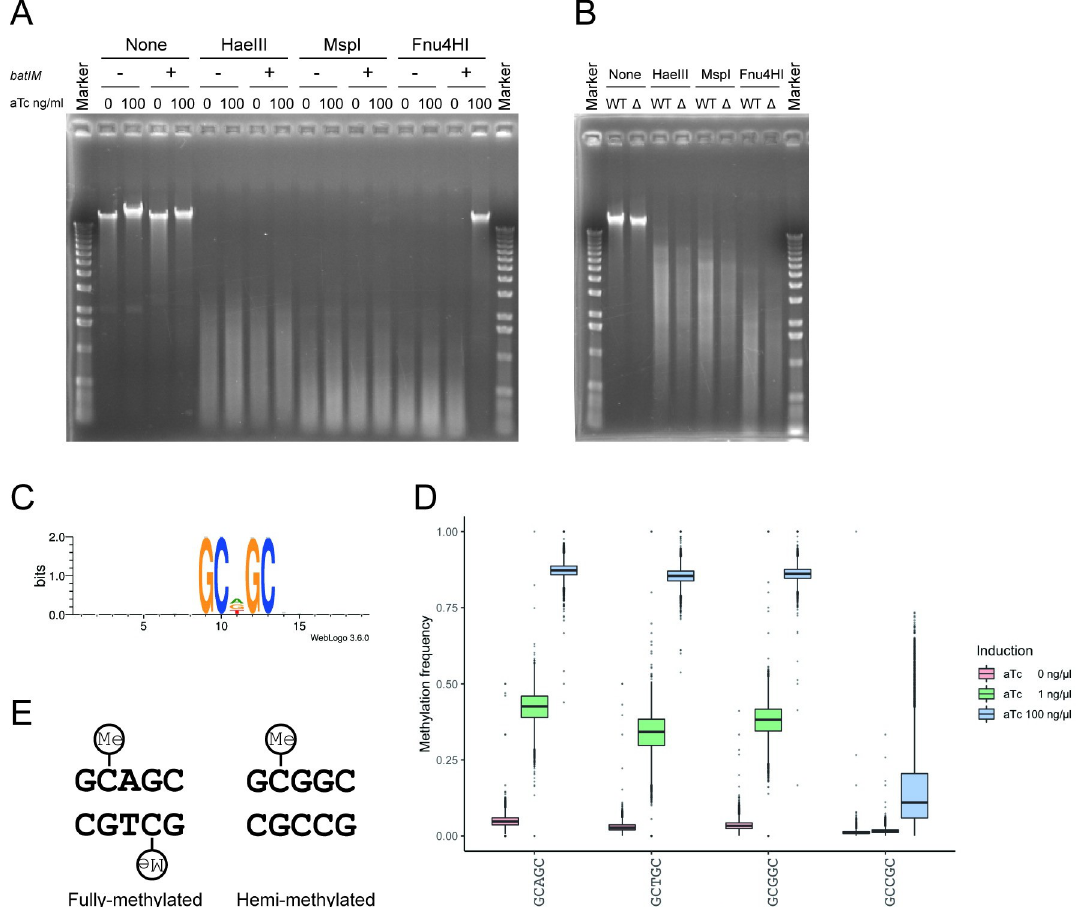
Fig 2. M.BatI fully-methylates 5’-GCWGC-3’ and hemi-methylates 5’-GCSGC-3’. (A) Digestion of genomic DNA of E . coli after inducing M.BatI production. Genomic DNA isolated from BYF823 ( batIM -) or BYF822 ( batIM +) induced with aTc 0 or 100 ng/ml was treated with specific restriction enzymes or untreated as controls. (B) Digestion of genomic DNA of wildtype (WT) and batIM knockout ( Δ ) strains of B . anthracis . (C) Sequence logo of sites around cytosines detected, by bisulfite sequencing, to be highly methylated. (D) Boxplots of methylation frequency of each sequence included in 5´- GCNGC -3´. (E) Fully-methylated and hemi- methylated motifs produced by M.BatI. Methylated cytosines were depicted with “Me” in a circle.